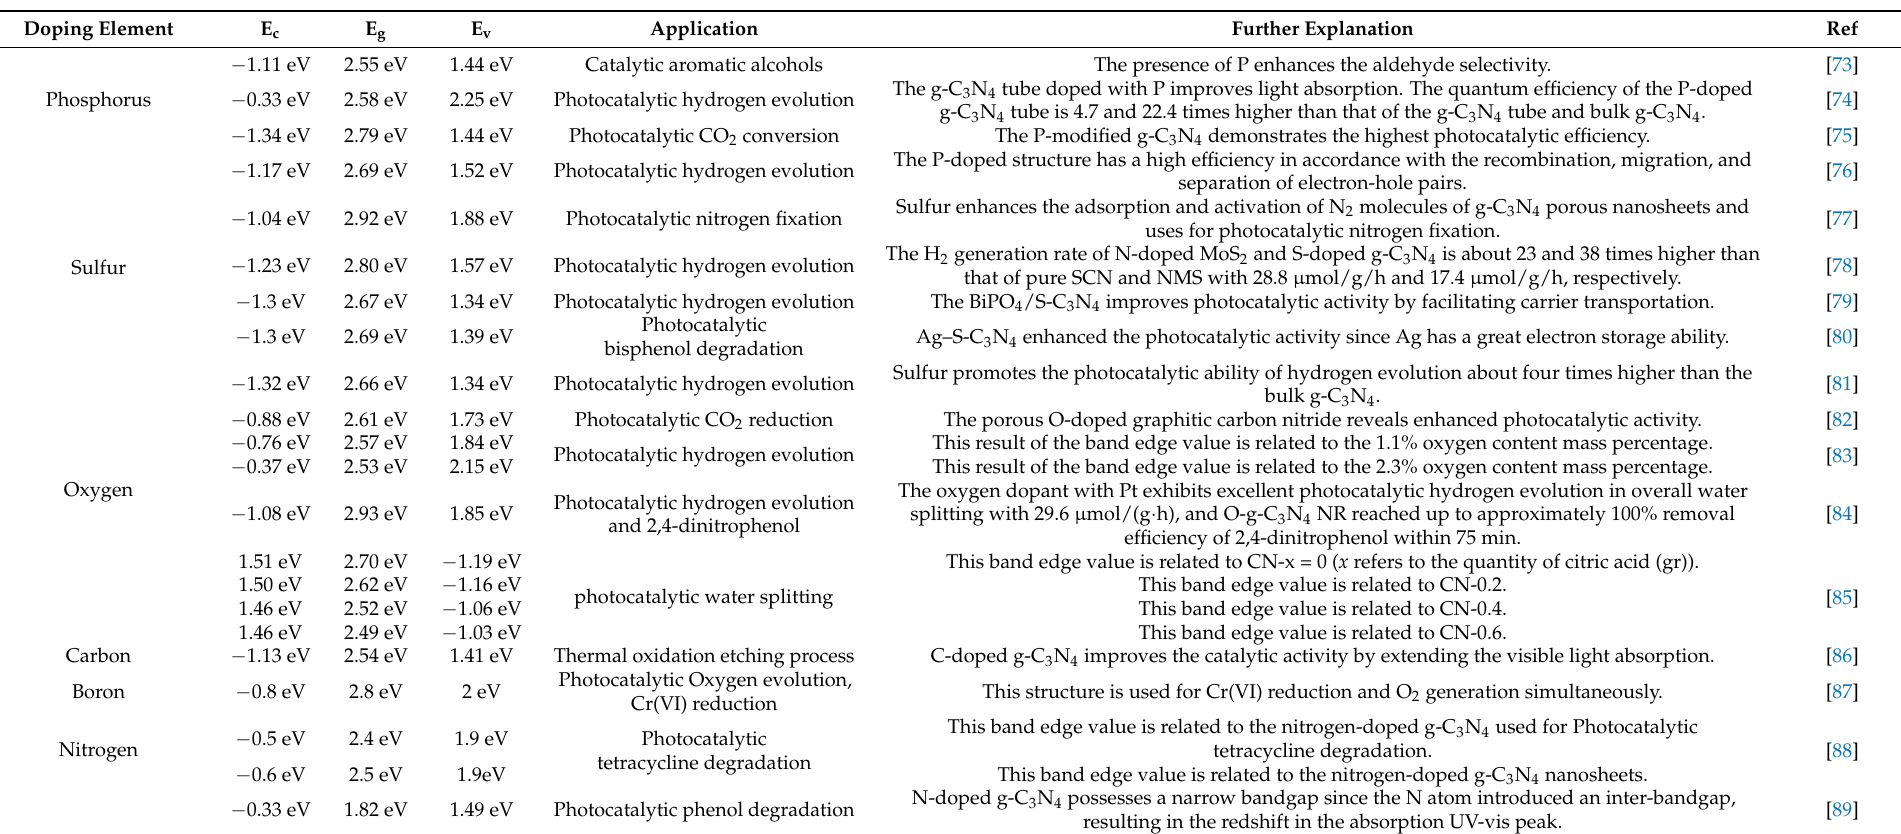
Table 1. The electrical properties and application of doped g-C 3 N 4